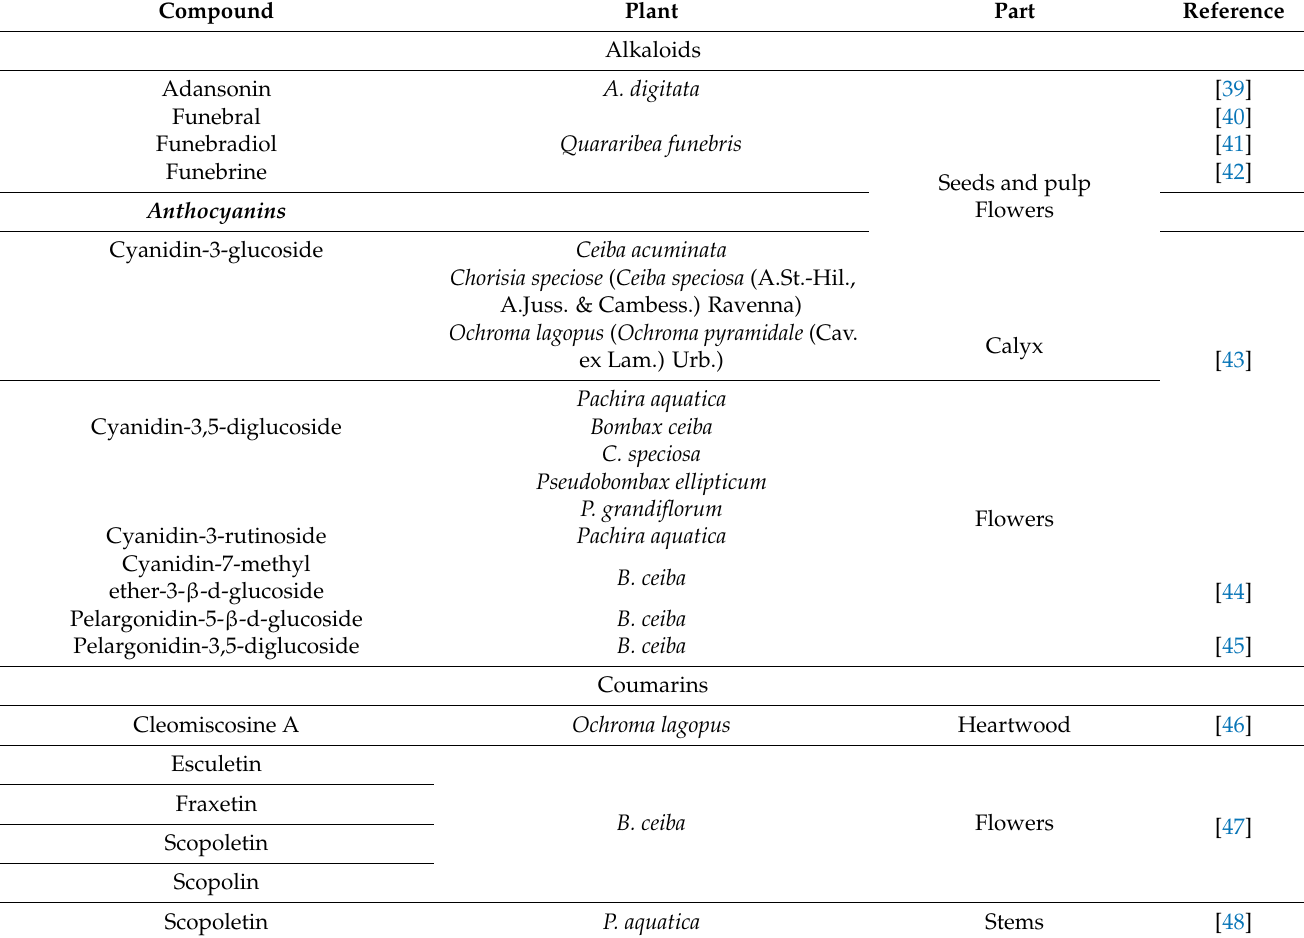
Table 2. The main phytochemicals identified in plant species from the Bombacoideae subfamily. Compound Plant